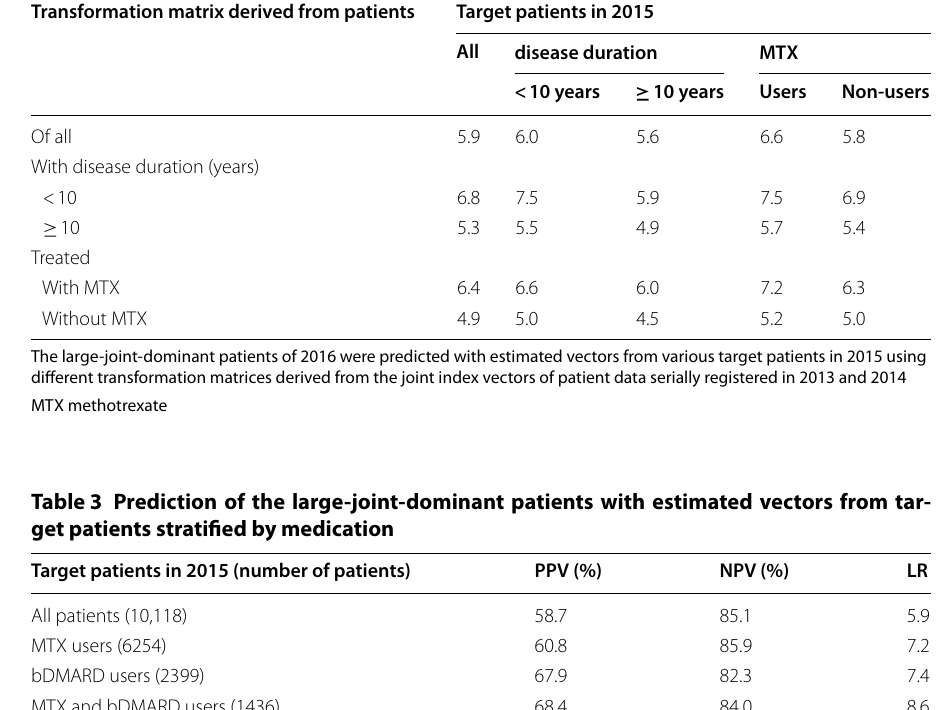
sensitivity/(1 specificity), MTX = −